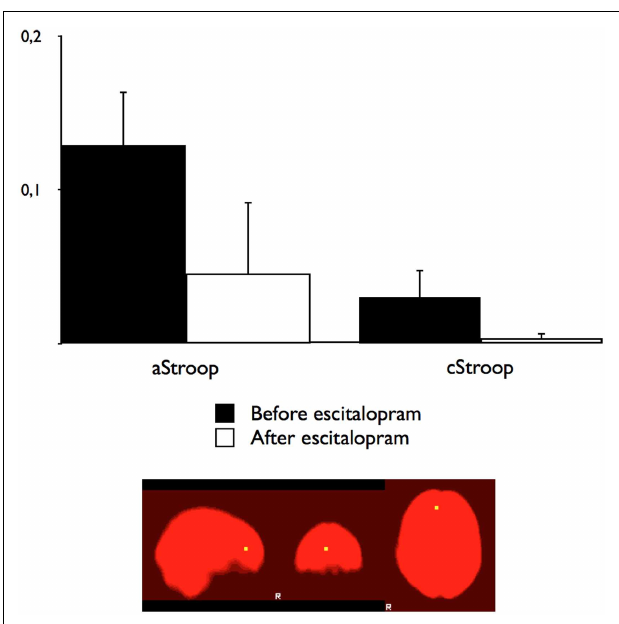
FIGURE 3 | Blood oxygen level dependant changes in the rightACC . The BOLD percentage changes in the right rostral anterior cingulate cortex for affective counting Stroop (aStroop) and cognitive counting Stroop (cStroop) before and after intake of escitalopram.The differences were not statistically significant.The mask was smoothed with a Gaussian kernel set to 1.5mm, surrounding the peak voxel shown in Figure 2A ( x , y , z : 6, 44,